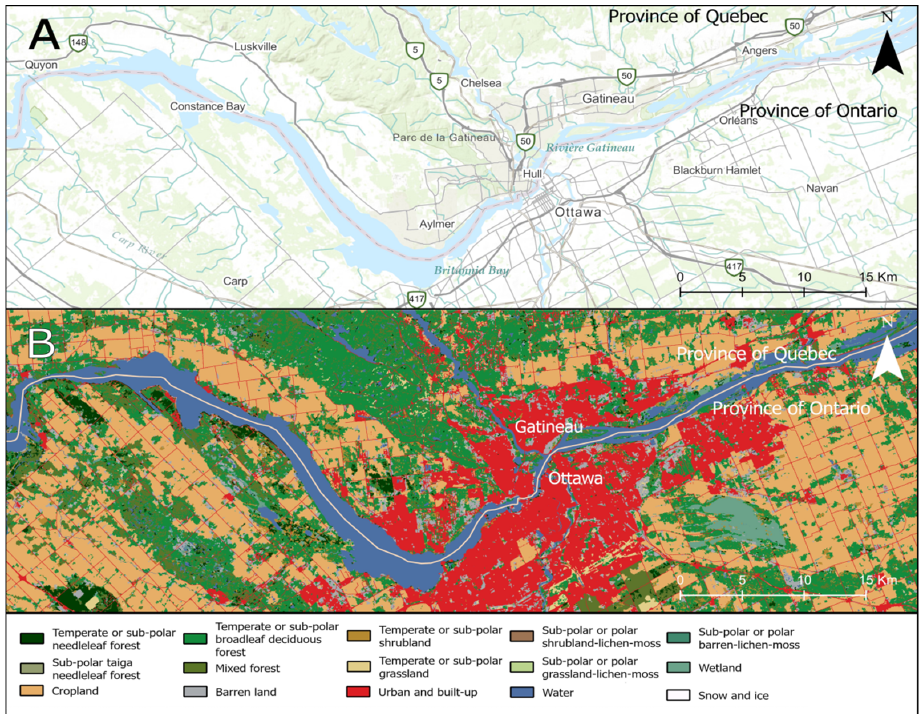
Figure 1. ( A ) topographic map with main roads and urban areas, from the World Topo Map (Esri, DeLorme, HERE, TomTom, Intermap, increment P Corp., GEBCO, USGS, FAO, NPS, NRCAN, GeoBase, IGN, Kadaster NL, Ordnance Survey, Esri Japan, METI, Esri China (Hong Kong), swisstopo, MapmyIndia, and the GIS User Community). ( B ) land cover map, from the 2015 Land Cover of Canada (Government of Canada, Natural Resources Canada, Canada Centre for Remote Sensing). The solid line within the Ottawa River represents the provincial boundary between the provinces of Ontario (Ottawa city) and Quebec (Gatineau city), from the Topographic Data of Canada CanVec Series (Government of Canada, Natural Resources Canada, Canada Centre for Remote Sensing).